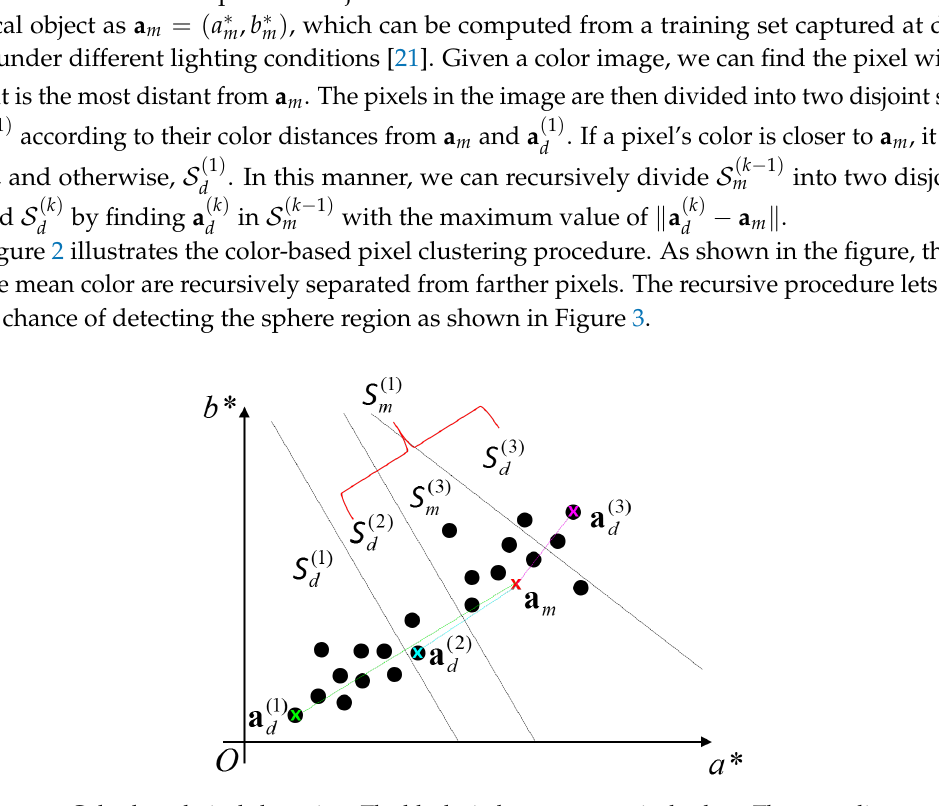
( 1 ) ( 1 ) and S m , which is the union of d